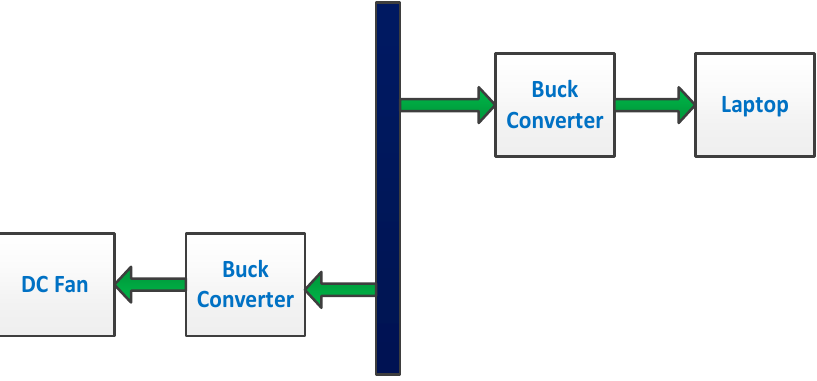
Figure 5. Proposed arrangement for <24 V devices.